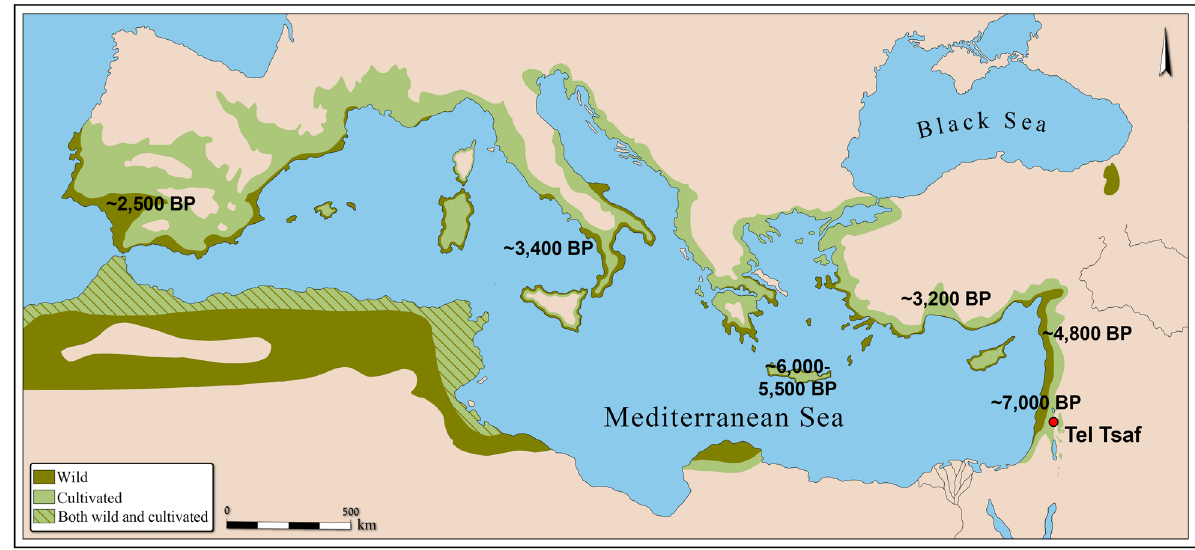
Figure 5. Geographical distribution of wild olive ( Olea europaea subsp. oleaster ) and cultivated olive in the Mediterranean Basin (modified after 48–50 ) together with suggested dates for the beginning of olive horticulture in the Mediterranean regions 50